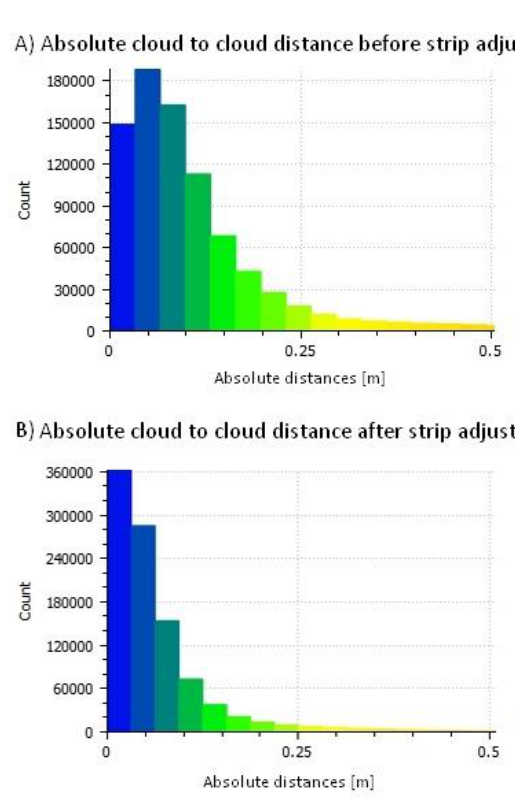
Figure 8. A histogram presenting the absolute distance between point clouds from neighbouring strips: